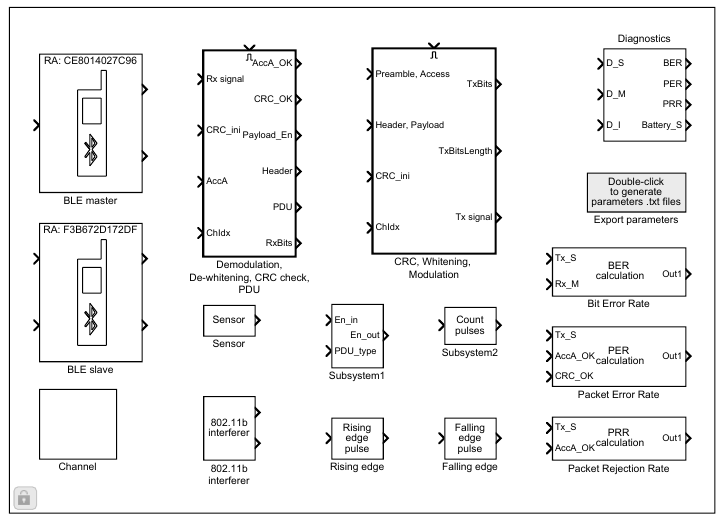
Figure 1. Bluetooth Low Energy (BLE) wireless sensor network library in MATLAB Simulink.